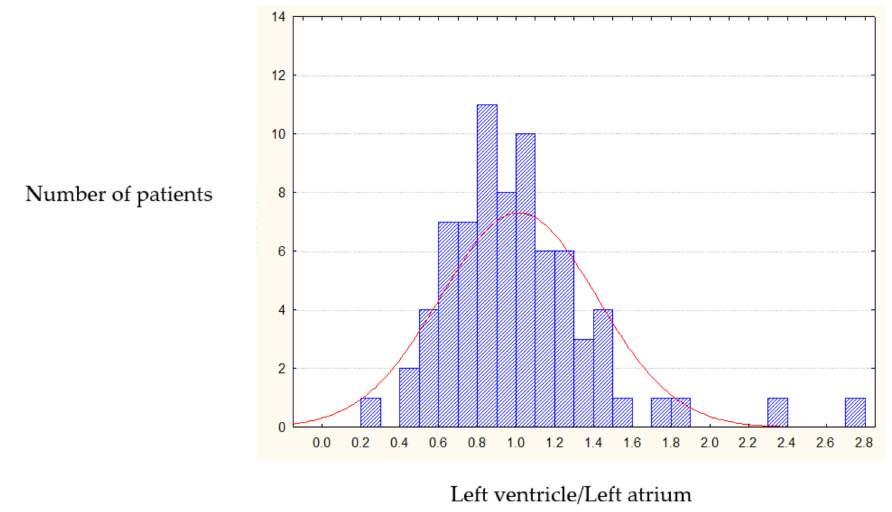
Figure 3. Post-operative IRV distribution (left heart